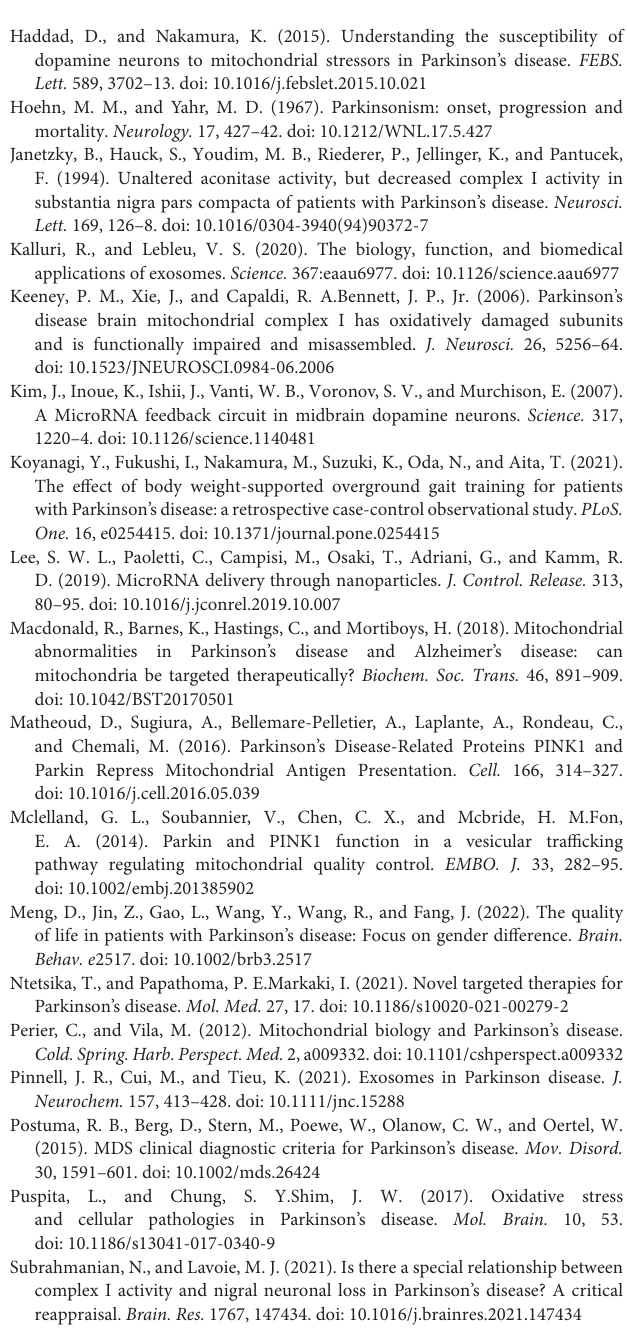
Supplementary Figure 1 | Identification of exosomes. Transmission electron microscopy. White arrow heads point to exosome (A) . Western blotting exosomes are positive for CD9 (B) and CD81 (C)